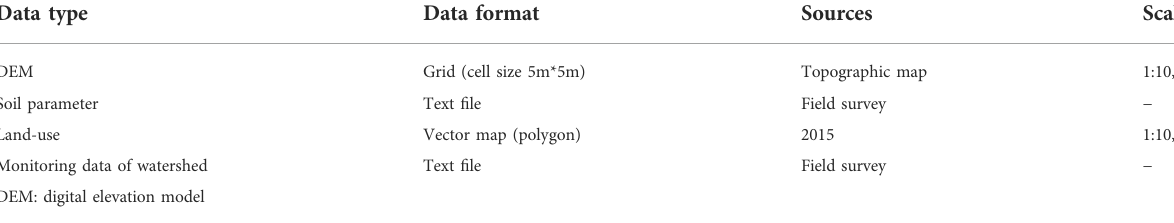
TABLE 1 Data format and sources for the study watershed.